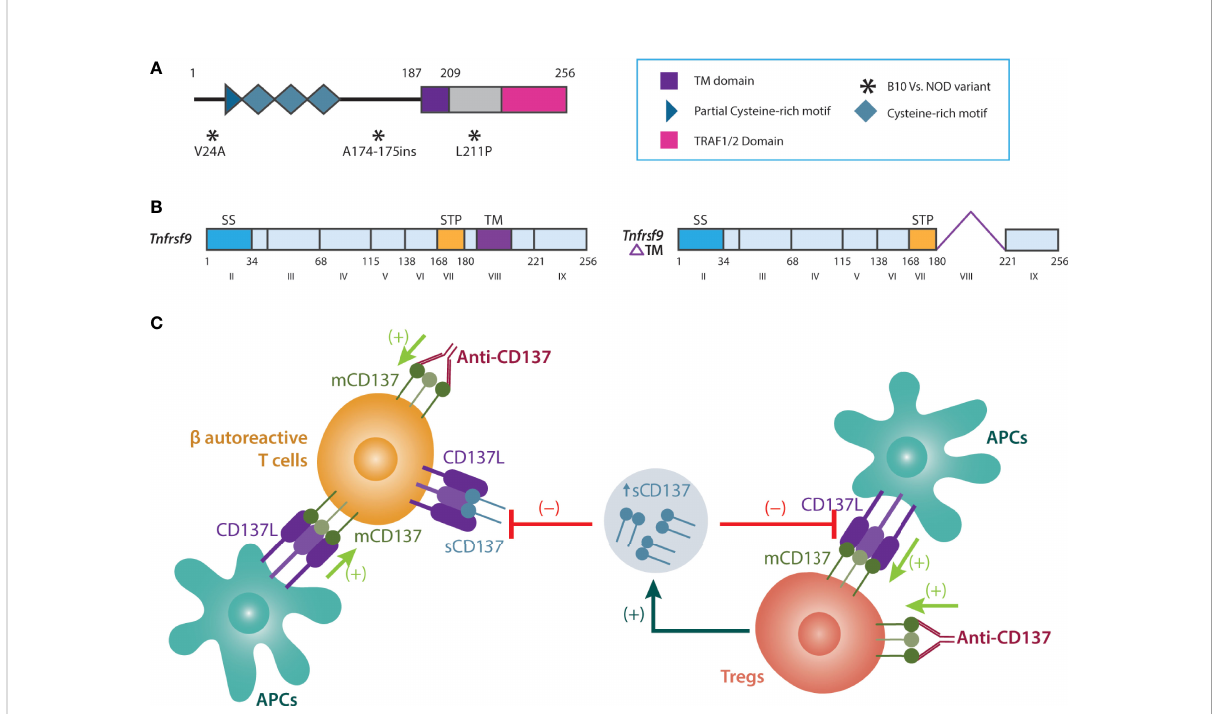
FIGURE 2 Biology and function of sCD137. (A) Non-synonymous SNPs of NOD vs. B6 Cd137 . (B) membrane vs. soluble (alternatively spliced) CD137. (C) Tregs produce sCD137 with a dimeric structure. sCD137 induces altered CD137L signaling in APCs and autoreactive T cells (compared to membrane CD137), reducing in fl ammation and damage in the pancreas. In contrast to sCD137, although anti-CD137 antibodies activate Tregs (a strong immune regulatory effect), they may also increase autoreactive T cell survival and proliferation, thus perpetuating in fl ammation and autoimmunity. APCs, Antigen-presenting cells; CD137L, CD137 Ligand; mCD137, Membrane-bound CD137; NOD, Non-obese diabetic; sCD137, Soluble CD137; SS, signal sequence; STP, Ser/Thr/Pro-rich; T1D, Type 1 diabetes; TM, Transmembrane domain; Tregs, T regulatory